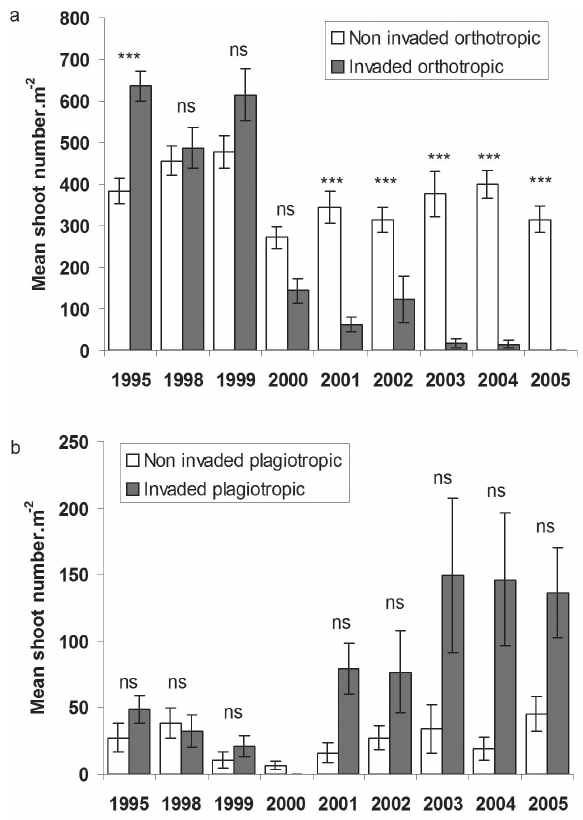
Fig . 3. – Mean number of orthotropic (a) and plagiotropic (b) shoots of Posidonia oceanica, from 1995 to 2005, at the control site of Cap d’antibes (white bars) and the invaded site of Cap Martin (grey bars). error bars represent ± se. Multiple comparison test in-